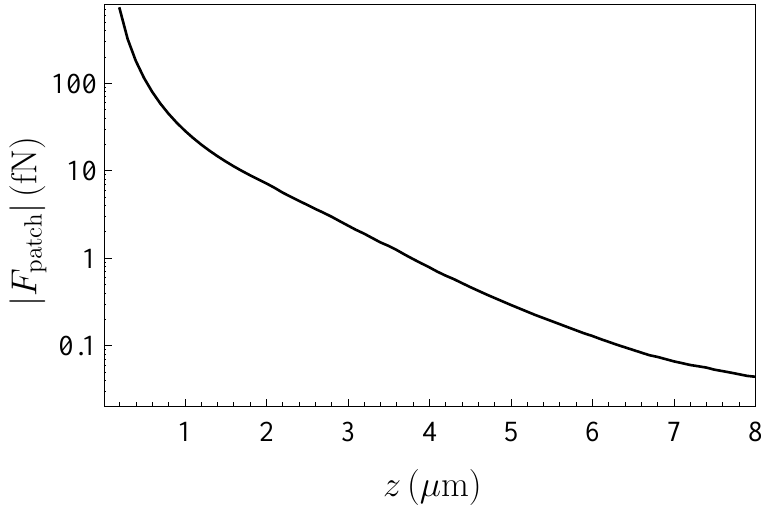
Figure 4. An estimated magnitude of the force originating from surface patches as a function of separation (in a logarithmic